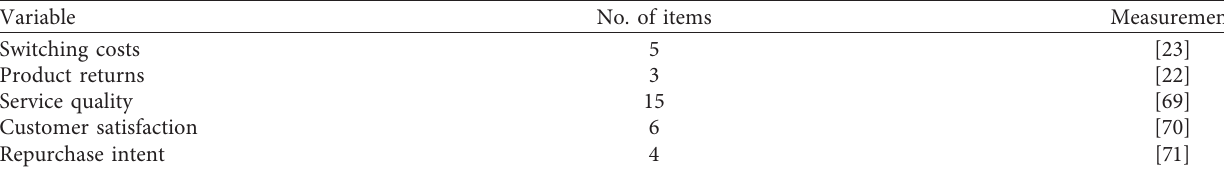
Figure 1: Diagrammatic representation of the relationships among study variables (theoretical Table 2: Measurement of study variables.